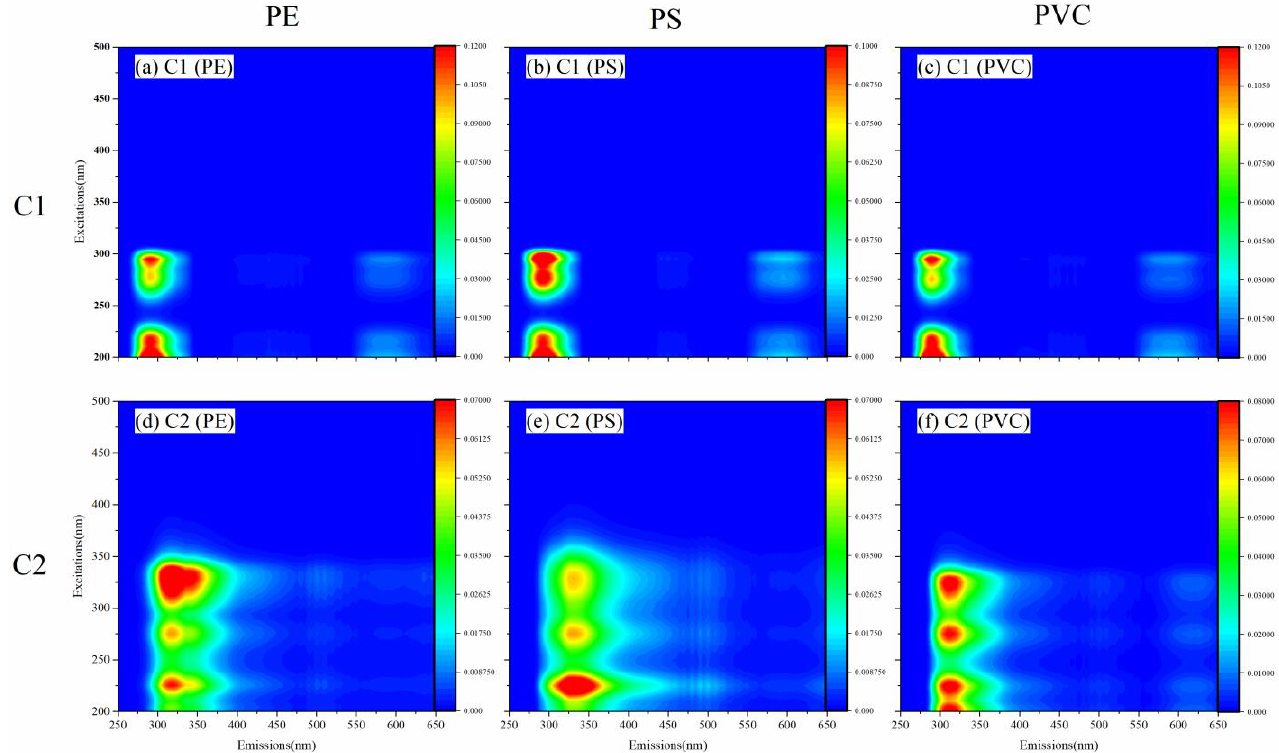
Figure 4. PARAFAC model output showing 2 different fluorescent components of 3 types of MP- DOM: ( a ) C1 for PE-DOM; ( b ) C1 for PS-DOM; ( c ) C1 for PVC-DOM; and ( d ) C2 for PE-DOM; ( e ) C2 for PS-DOM; ( f ) C2 for